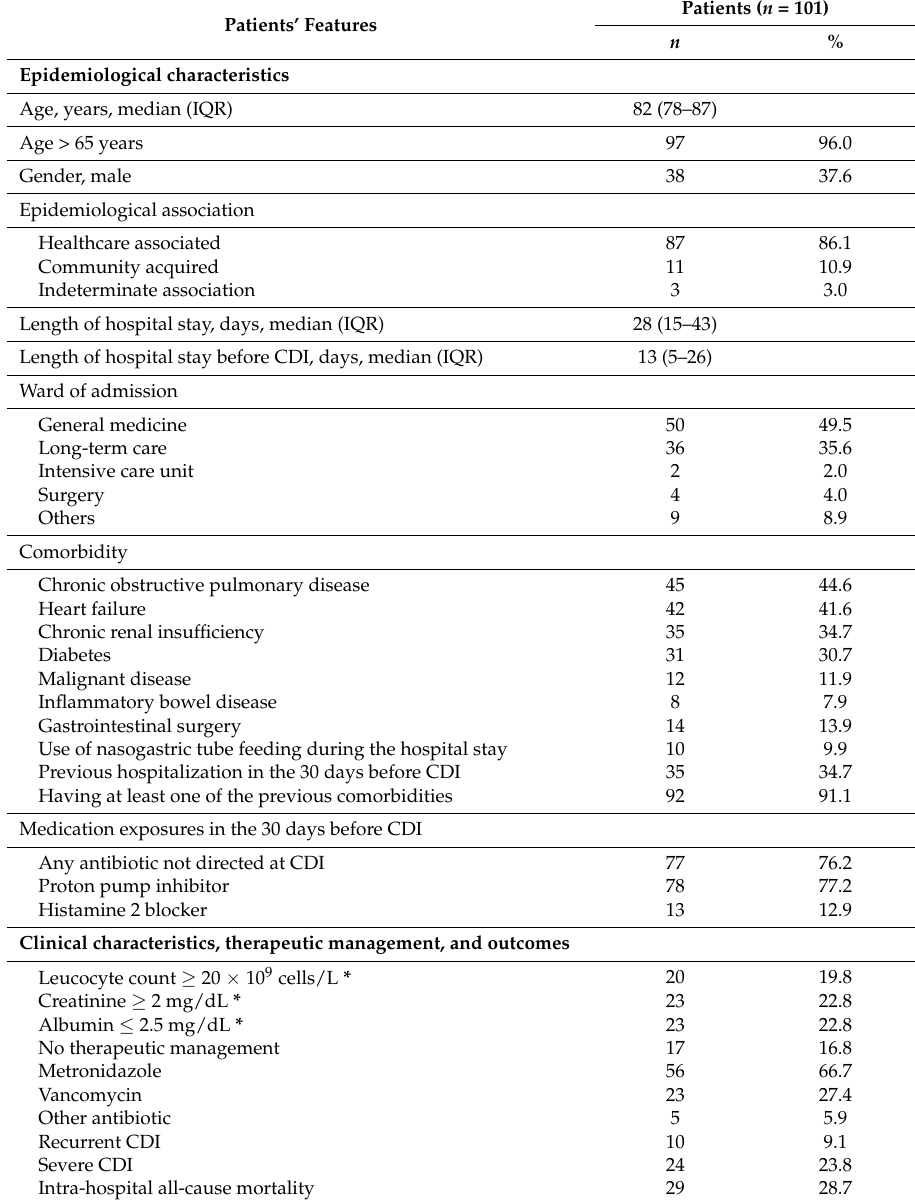
Table 4. Epidemiological and clinical characteristics, therapeutic management, and outcomes of CDI patients (retrospective